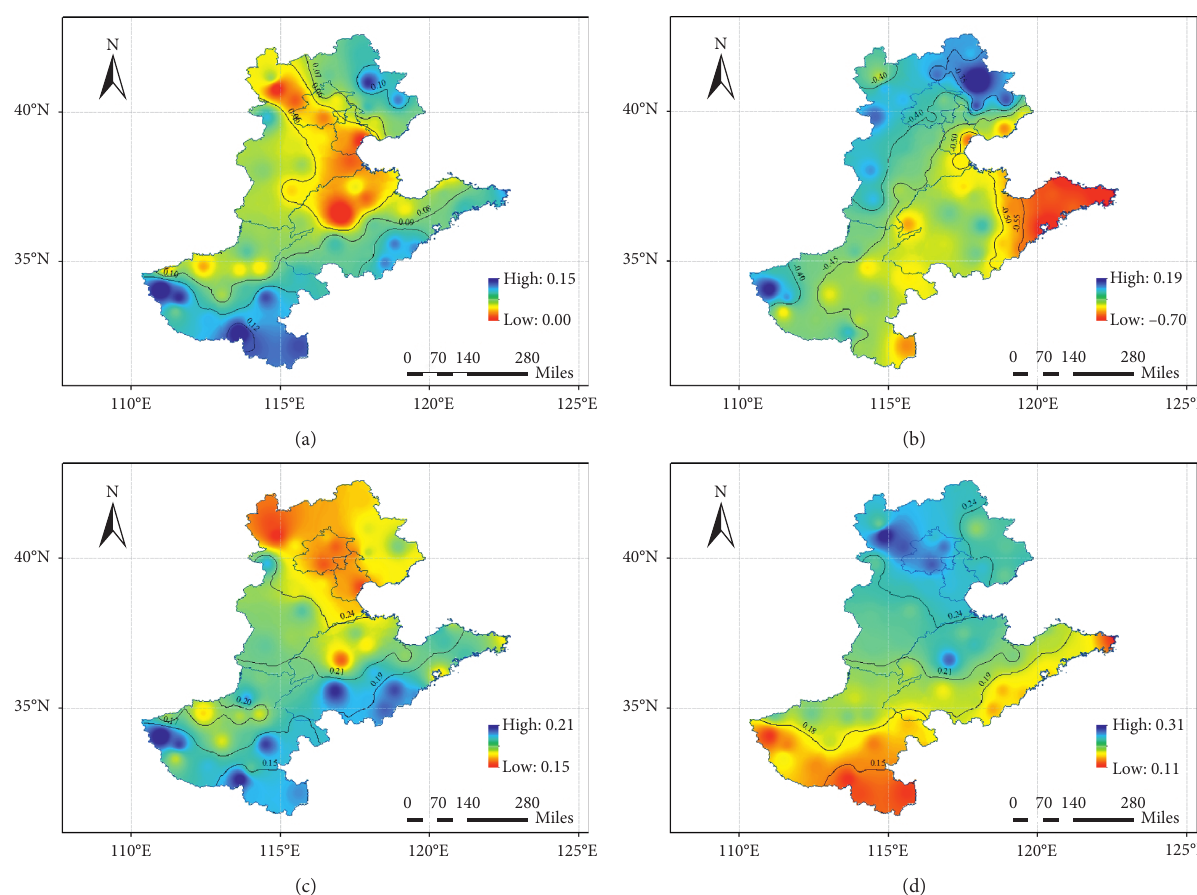
Figure 4: Spatial distribution of sensitivity coefficient of the main meteorological factors affecting ET (b) Relative humidity. (c) Sunshine hours. (d) Wind